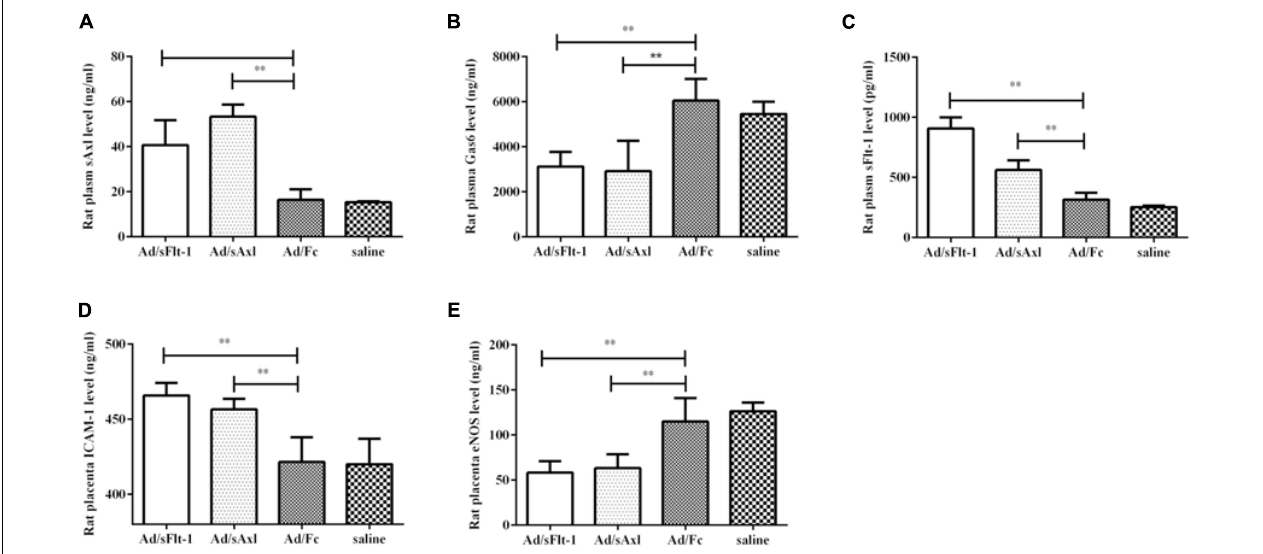
FIGURE 7 | Effects of sAxl on rat vascular endothelial sAxl, Gas6, sFlt-1, and adhesion molecules. (A–C) The expression of sAxl, Gas6, and sFlt-1 in plasma. (D,E) ICAM-1 and eNOS expression levels in the placenta. The results are presented as mean ± SD. ** p < 0.01 vs. respective controls. n = 6 per